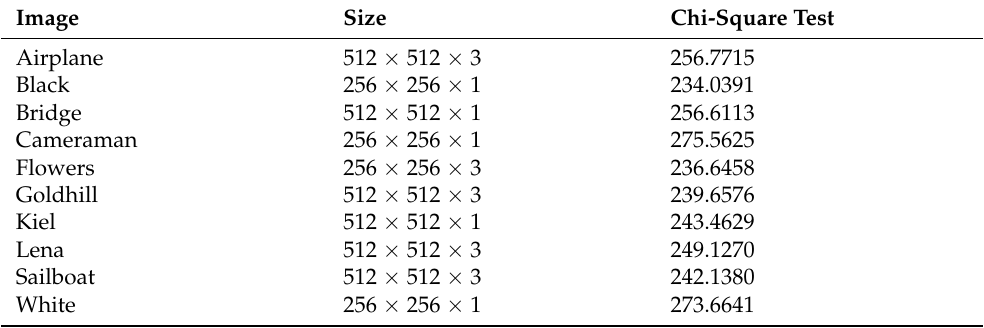
Table 7. Chi-square